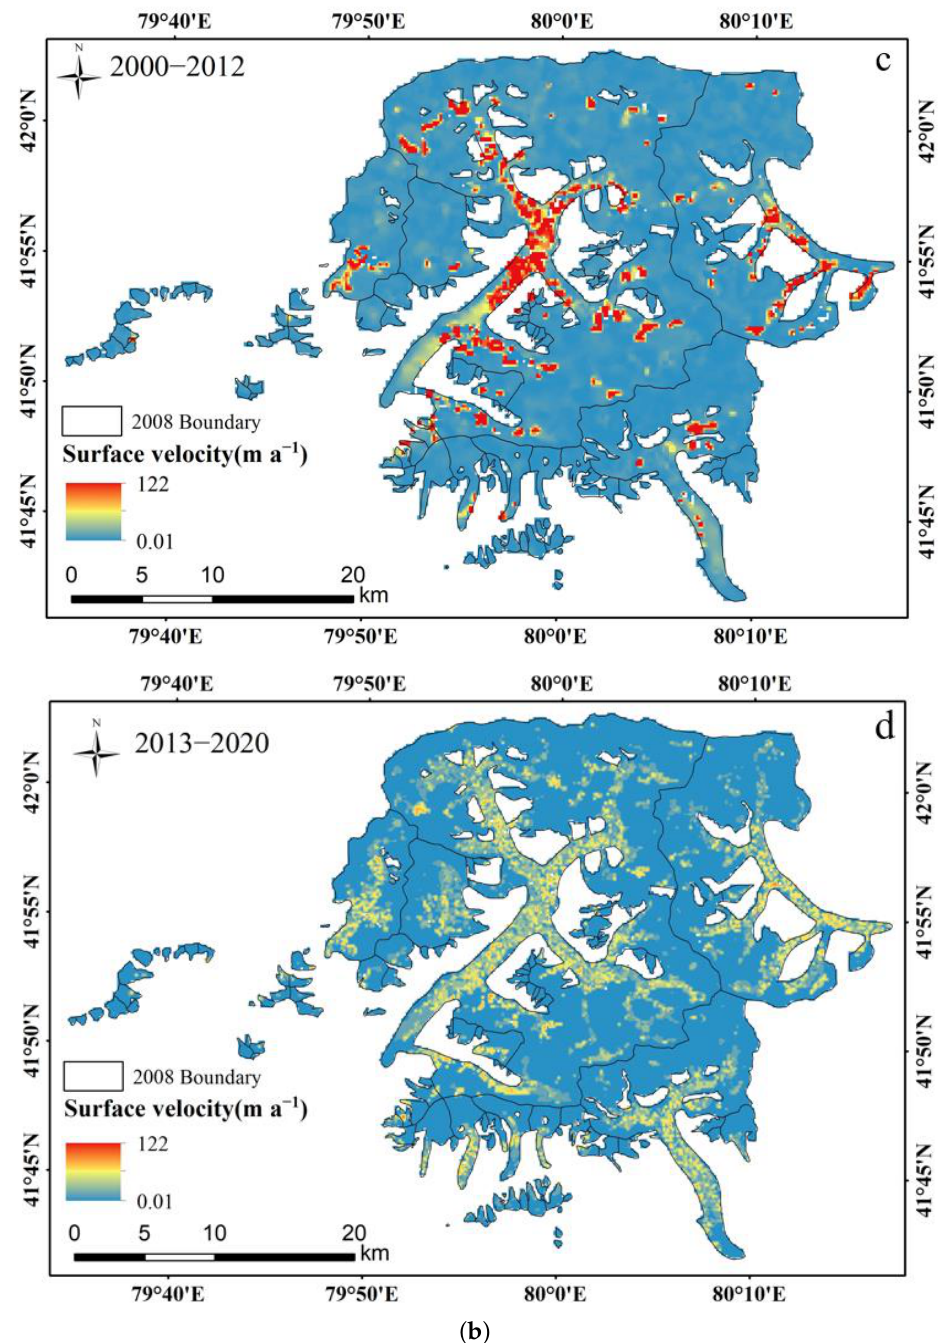
Figure 3. ( a ) interannual variation of glacier movement velocity in the Tomur Peak area, ( b ) distribution of the annual average velocity of glaciers in the altitude zone (3000 m – 6800 m) from 2000 to 2020, ( c ) distribution of the annual average velocity of glaciers from 2000 to 2012, and ( d ) distribution of the annual average velocity of glaciers from 2013 to 2020.